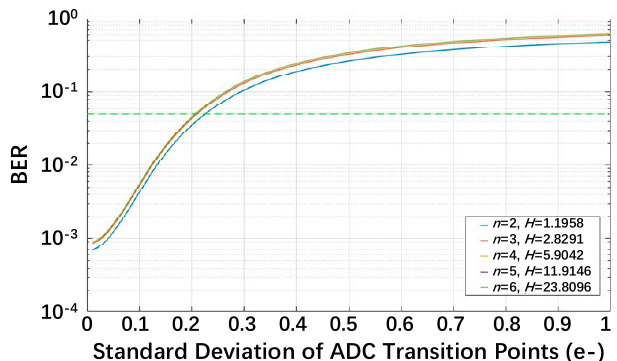
Figure 7. The BER as a function of U thn for different QIS bit depths n and their relevant worst exposure for read noise U n = 0.15e − .